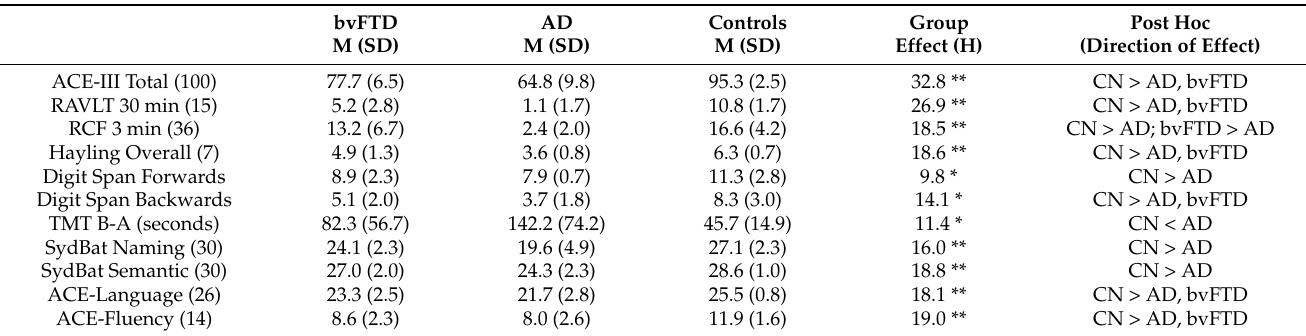
Table 2. Descriptive statistics and group differences on neuropsychological